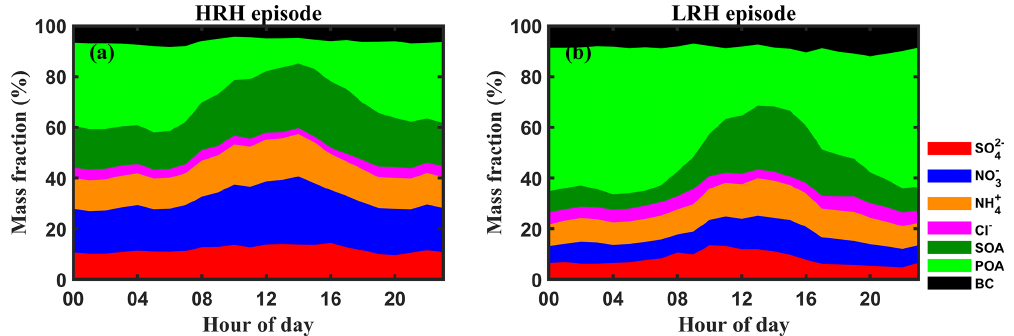
Figure 7. Diurnal variation of the mass fraction of SO 42 − , NH 4 + , Cl − , NO 3 − , BC, POA, and SOA in particle phase during the HRH and LRH